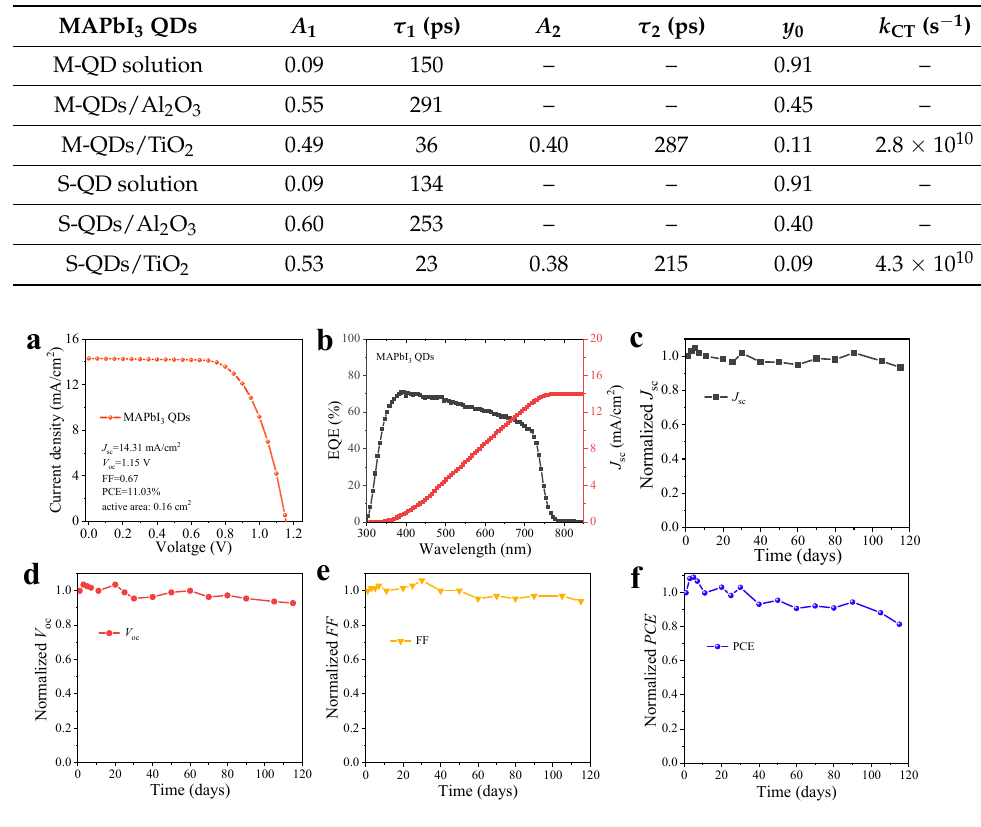
Figure 8. ( a ) The J–V curve and ( b ) corresponding EQE of MAPbI 3 QDs/TiO 2 -based solar cell. Evolution of the normalized ( c ) short-circuit current density ( J sc ), ( d ) open-circuit voltage ( V oc ), ( e ) fill factor ( FF ) and ( f ) power conversion efficiency ( PCE ) of QD solar cell, which was kept in a dry cabinet (<30% humidity) and measured in ambient air.